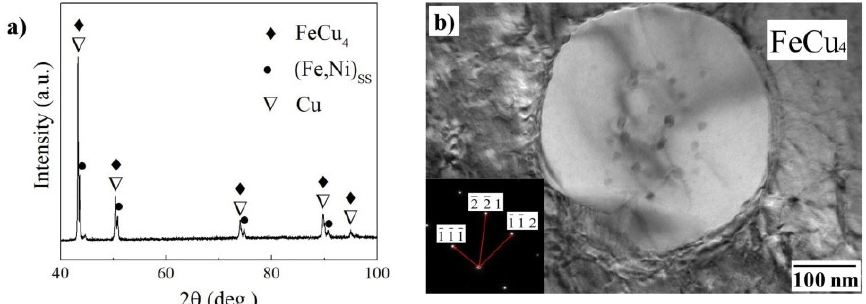
Figure 11. XRD results and TEM images for the first copper layer. ( a ) XRD results of the deposition, ( b ) morphology of FeCu 4 [128].